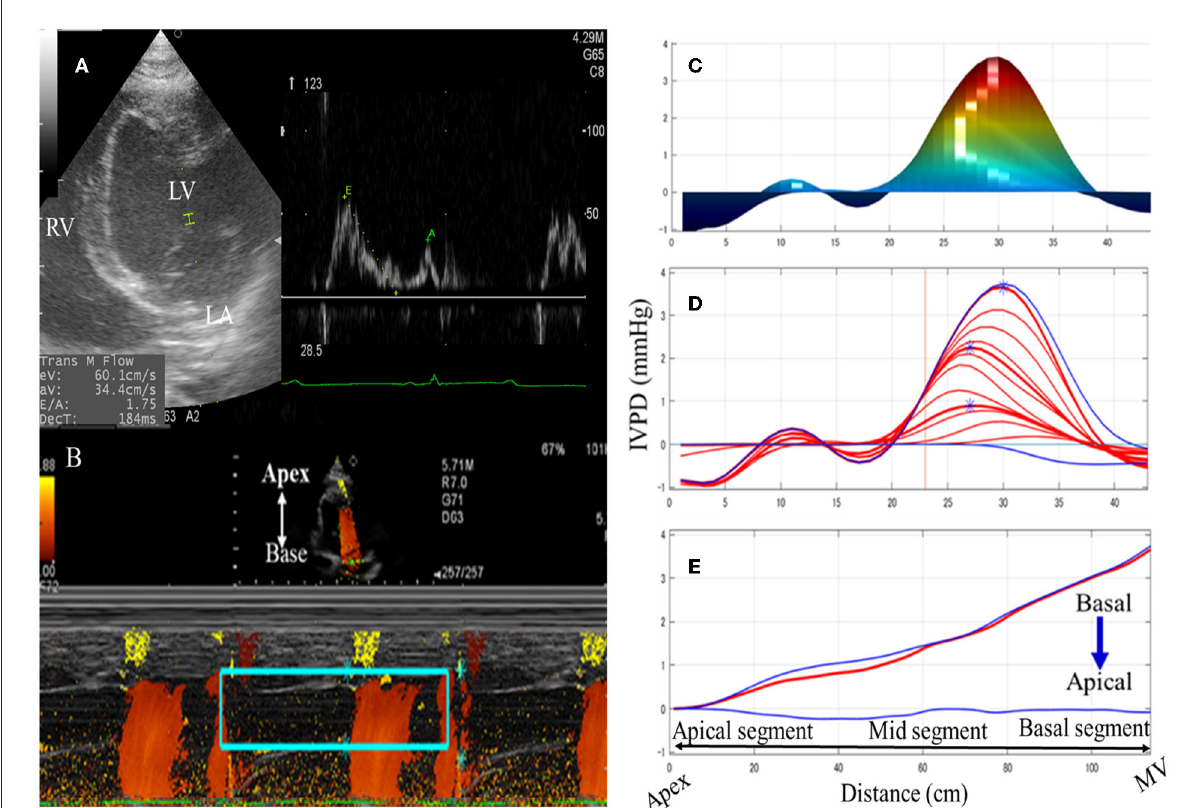
FIGURE1 Schematic illustration of color M-mode echocardiographic (CMME) in goats. The left apical four-chamber view was optimized to evaluate the mitral inflow (A) . After that, the proper machine setting was started to initiate CMME. IVPG tracing was switched on to trace the entire left ventricular inflow tract from the LV base to the apex. Captured CMME images (B) were used for IVPD/IVPG measurements of the area of interest (mitral inflow, rectangular green box) using MATLAB software based on Euler’s equation. Measurements of the time from q wave to the start of mitral inflow, from q wave to the peak mitral inflow, and from q wave to the end of aortic flow were separately added to the software’s dialog box using ECG displayed on the ultrasound machine. Manual correction of the analysis was limited to noisy photos so that the measurement area matches the IVPD/IVPG position by the software. Temporal and spatial profiles of IVPD (C) , and IVPD time distribution (D,E) were automatically calculated. MV, mitral valve; LV, left ventricle; LA, left